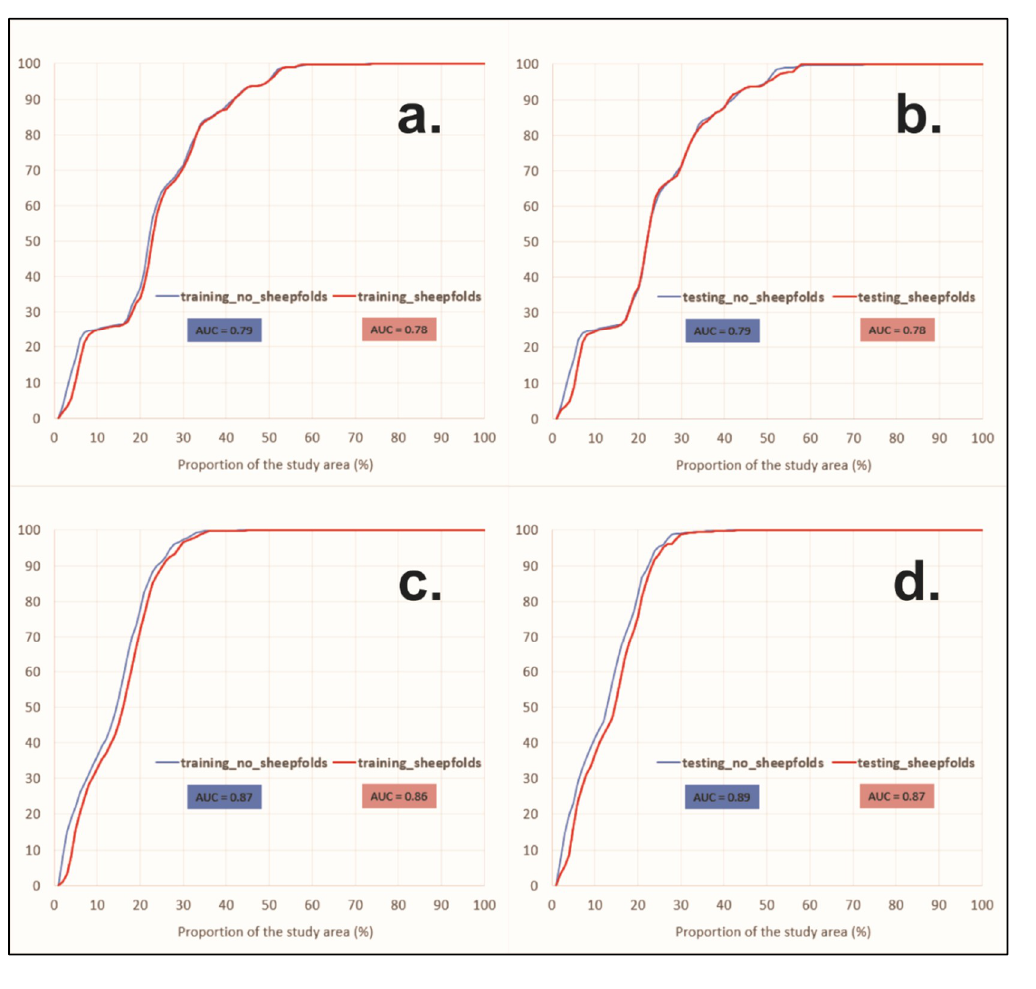
Figure 6. ( a ) Success rate curves produced with FR method, ( b ) prediction rate curves produced with FR method, ( c ) success rate curves produced with IV method, and ( d ) prediction rate curves produced with IV method. AUC—area under the curve.